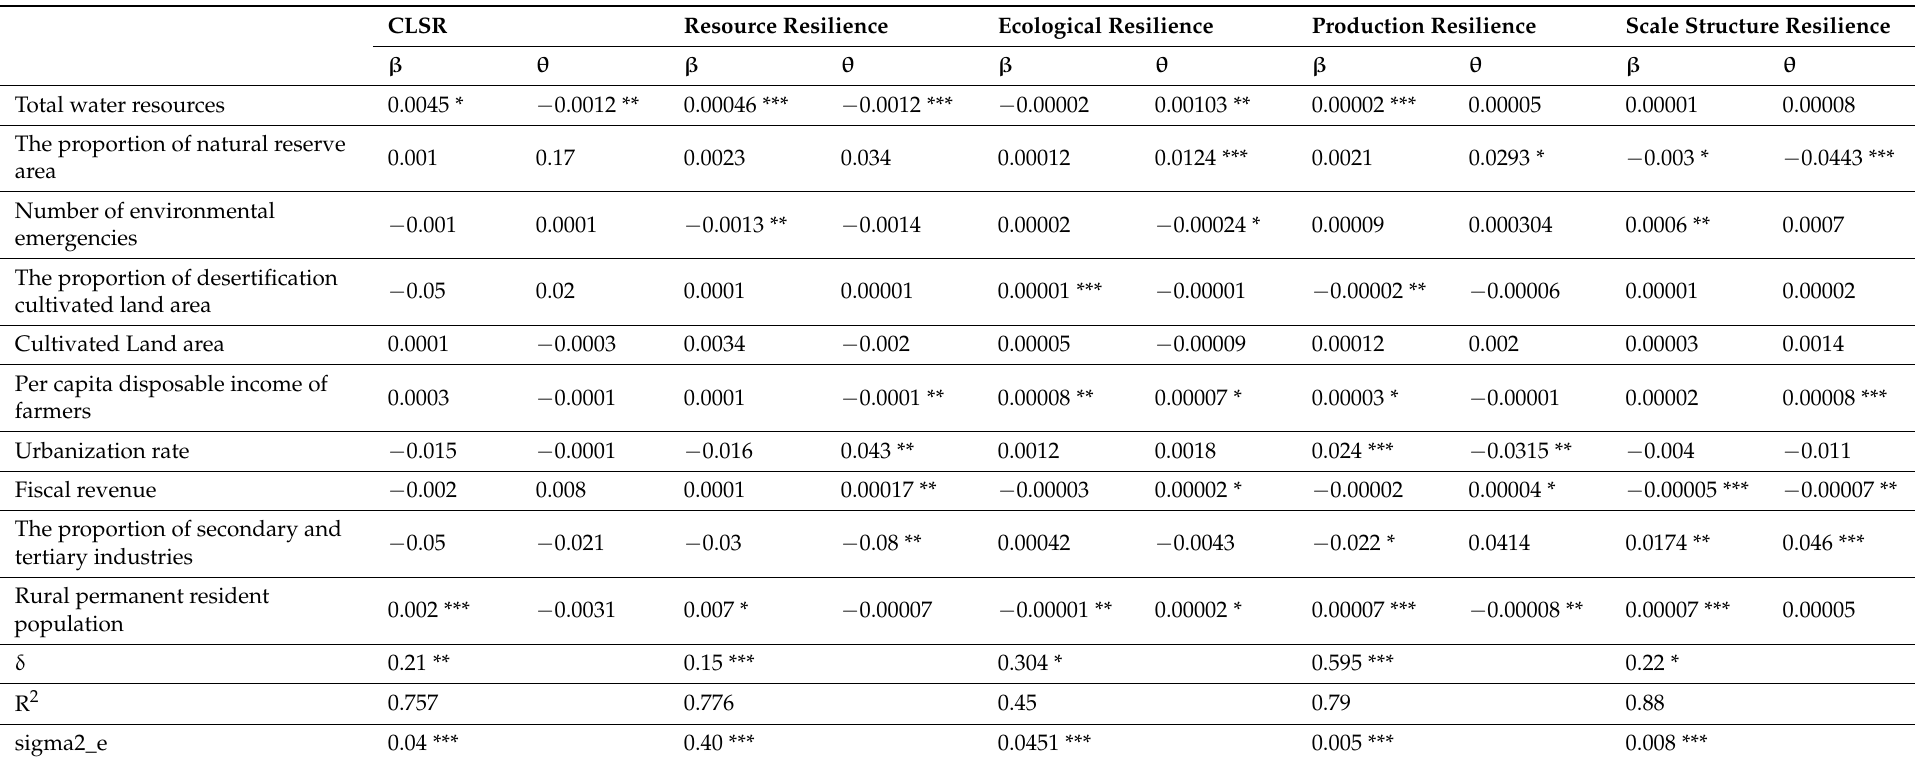
Table 5. Regression Results of the Spatial Durbin